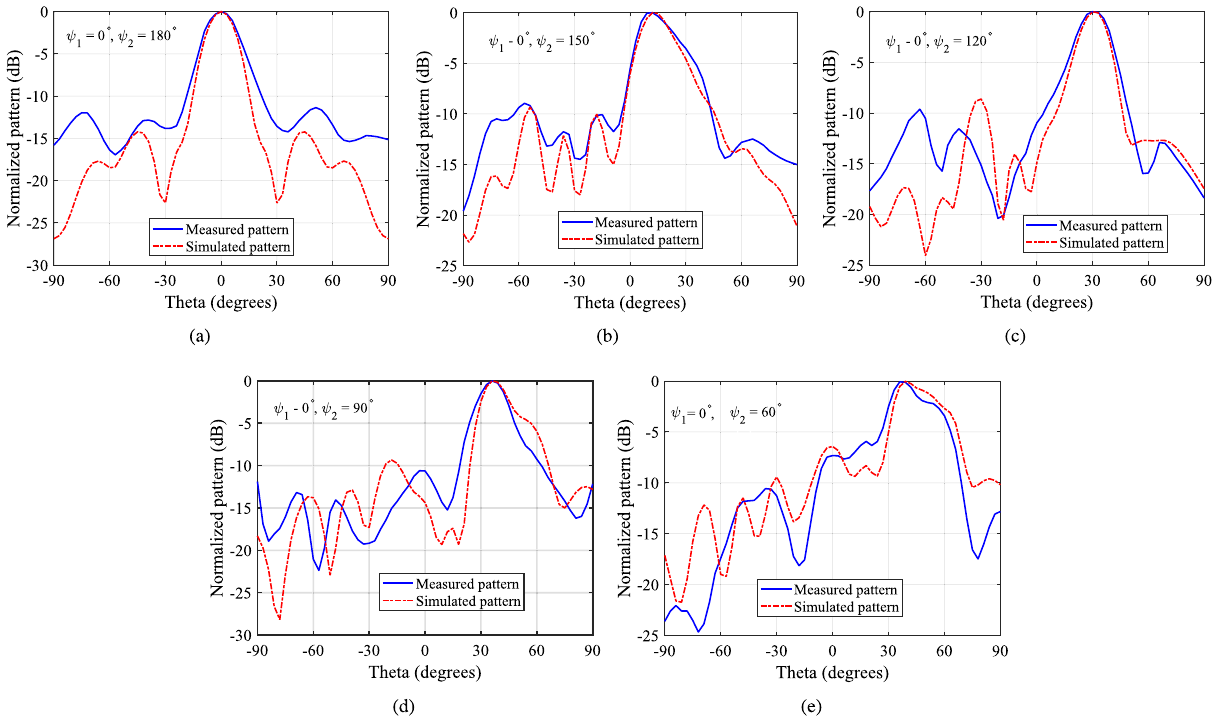
180 60 30 180 ◦ to ◦ at a step of ◦ : ( a ) ψ 2 = ◦ , ( b ) 60 ◦ . Each cut is taken at the elevation plane in which the